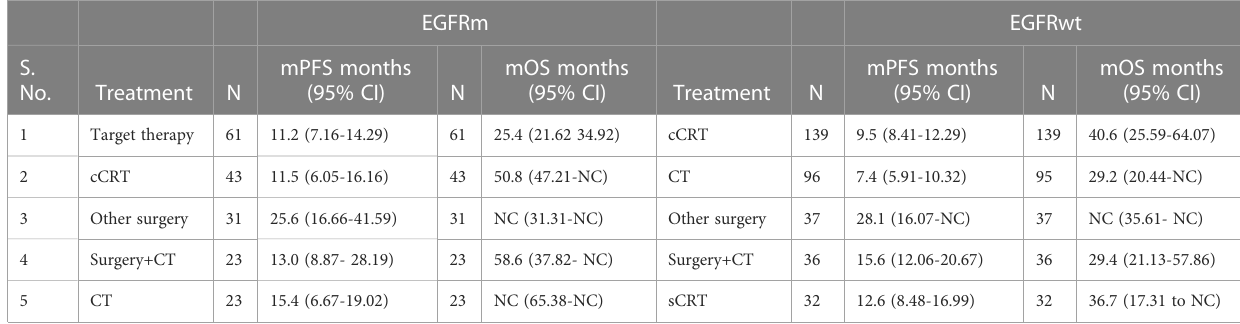
TABLE 3 Survival outcomes with top initial treatment patterns according to EGFR mutation status in KINDLE-Asia. EGFRm EGFRwt S.